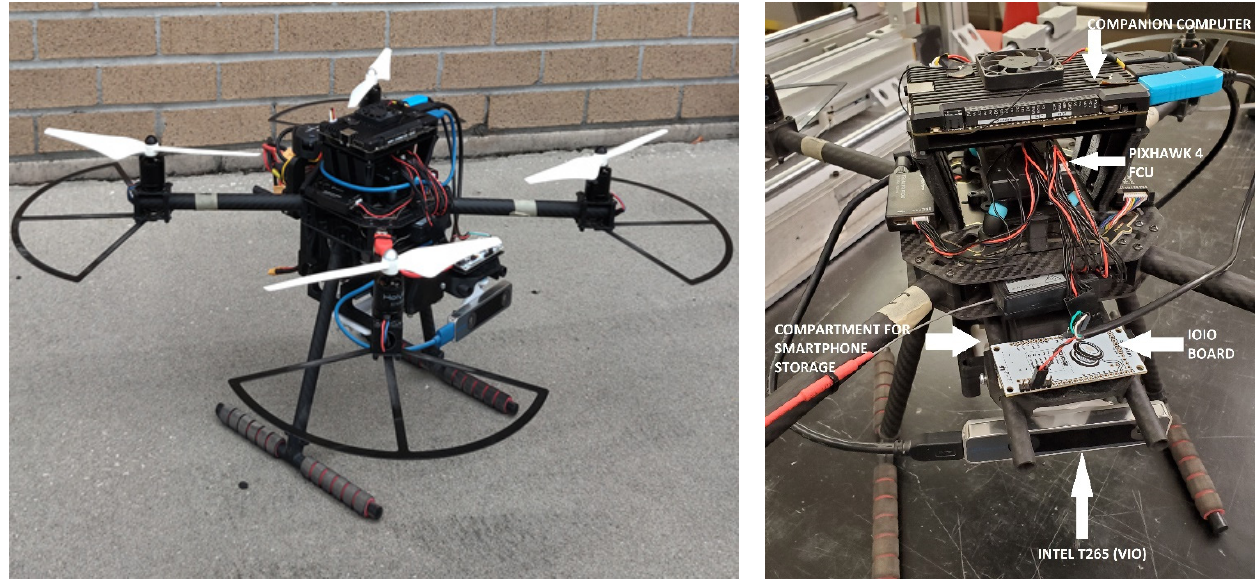
Figure 5. Flight platform used in the development and testing of landing experiments.